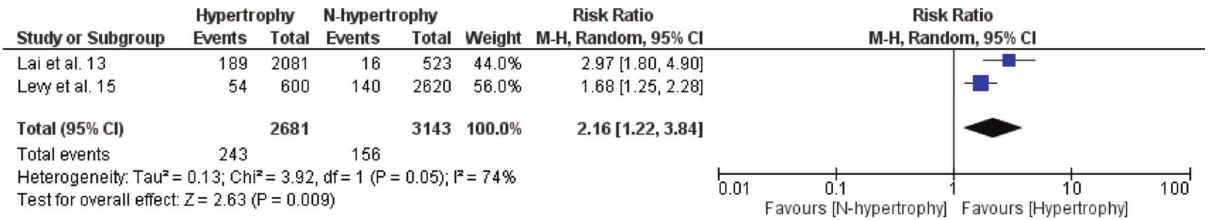
Figure 2.1 - The Risk Ratio and 95% confidence interval (CI) in the cardiovascular events (non-fatal), for Left Ventricular Hypertrophy group versus the Control group.